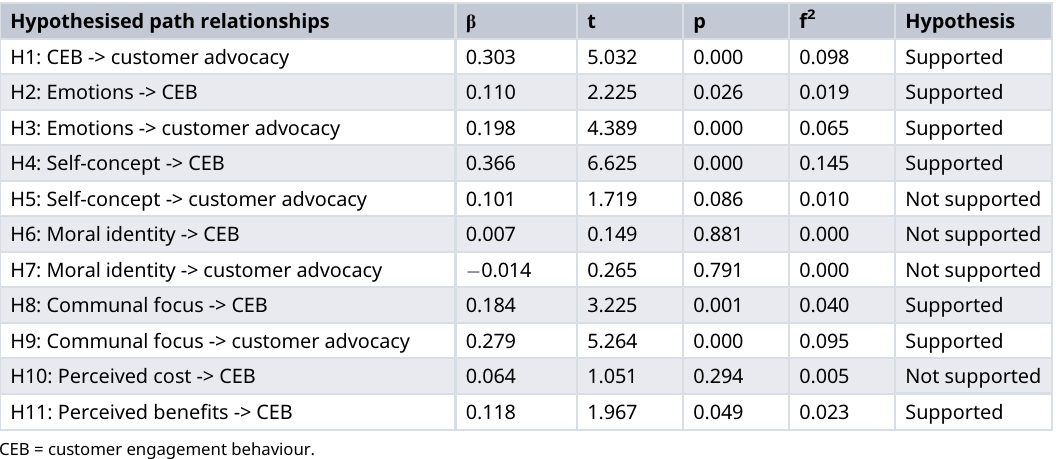
Table 3. Direct effects and effect sizes (f 2 ) of customer predispositions and engagement on advocacy behaviours. Hypothesised path relationships